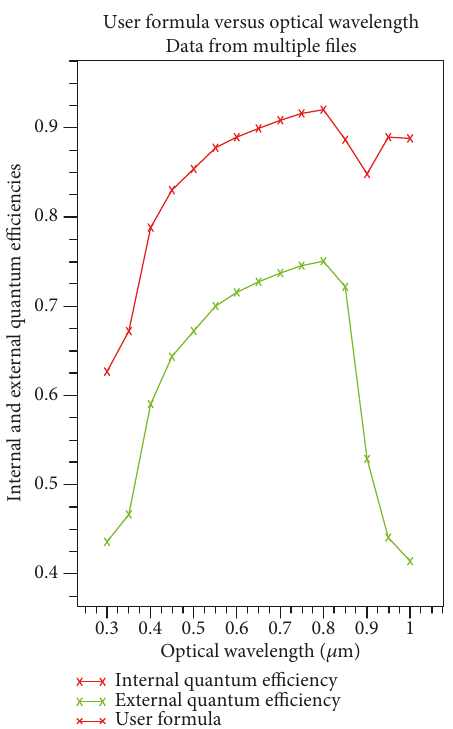
Figure 11: EQE and IQE of the optimized solar